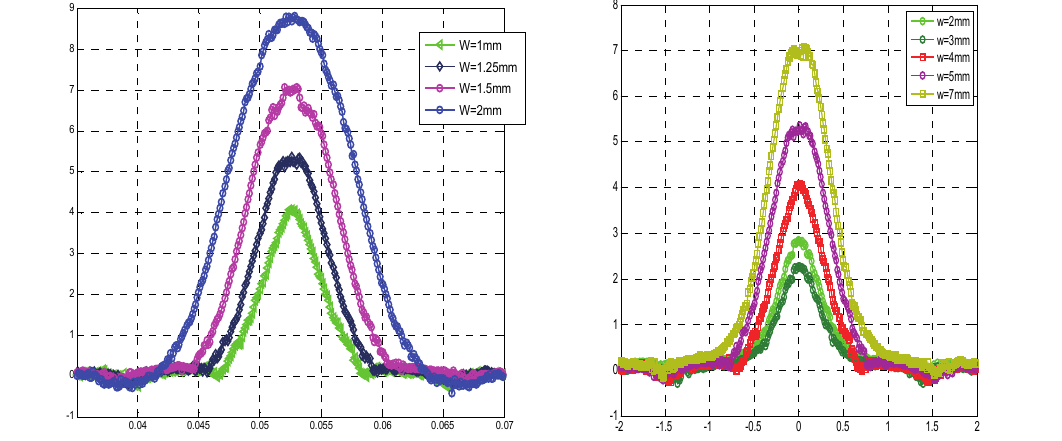
Figure 3: Impedance Z vs. the crack’s width. Figure 4: Impedance Z vs. the crack’s